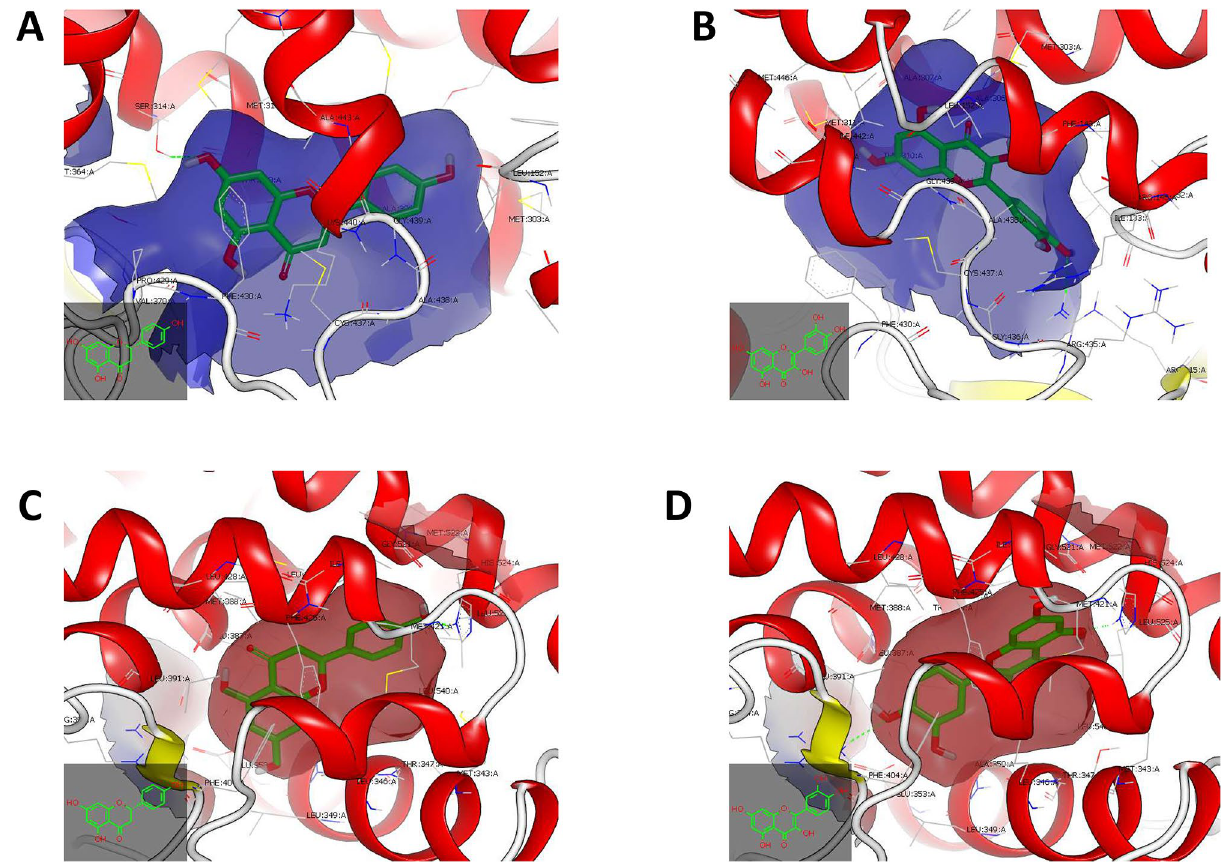
Figure 2. Visual representations of naringenin and quercetin towards aromatase and estrogen receptor ligand binding domains. ( A ) Visual representation of naringenin towards catalytic binding domain of aromatase enzyme, where the dotted green lines refer to the hydrogen bond towards SER 314:A. ( B ) Visual representation of quercetin towards catalytic binding domain of aromatase enzyme, where the dotted green lines refer to the hydrogen bond towards ARG115:A. ( C ) Visual representation of Naringenin towards estrogen receptor ligand binding domain, where the dotted green lines refer to the hydrogen bond towards HIS 524:A. ( D ) Visual representation of Quercetin towards estrogen receptor ligand binding domain, where the dotted green lines refer to the hydrogen bond towards ARG 394:A and HIS 524:A. Visualization was conducted using Vida application from the openeye package (www. eyeso pen.